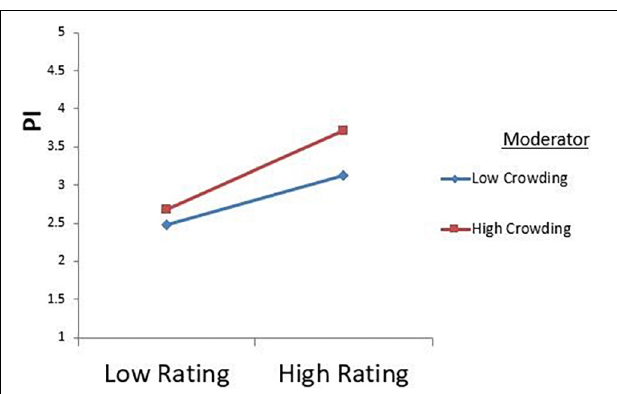
FIGURE 2 | Moderation graph.